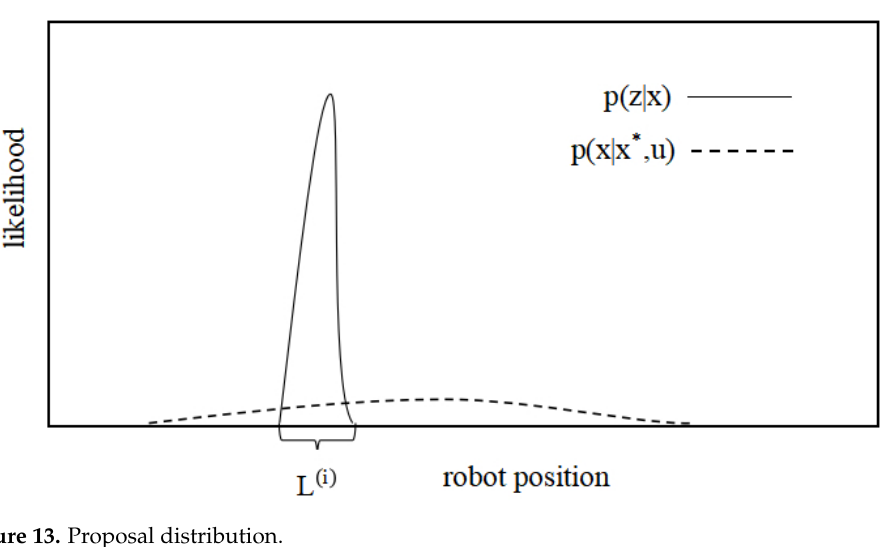
Figure 13. Proposal